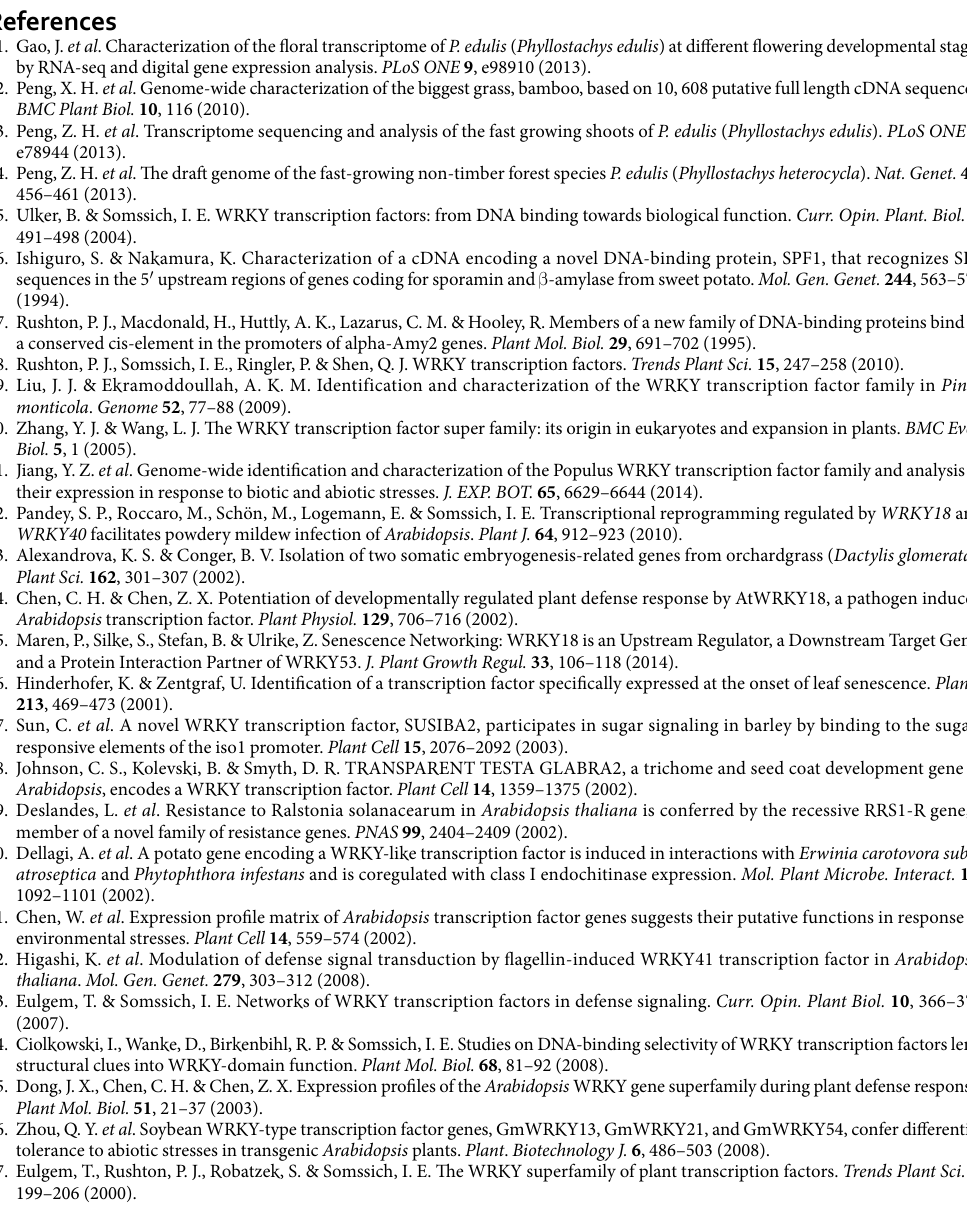
The construct vector was introduced into WT Arabidopsis plants (Columbia-0) by Agrobacterium -mediated transformation. Transgenic plants were selected on kanamycin, and the first generation of transgenic plants was examined in terms of their phenotypes. At least 10 independent transgenic plants exhibiting severe phenotypes were selected, subjected to phenotypic characterization and screened for the transgene. Transgenic Arabidopsis seeds (T3 generation) and WT seeds were cultured with 10% and 20% PEG solution on MS agar medium. One-week-old seedlings were used to observe the phenotype. Three-week-old transgenic plants and WT which growth in normal growth condition were treated with PEG solution for 3 h and further used for RT-PCR experi- ment and stomatal closure observation. The subcellular localization of PheWRKY72-2 was performed by transfecting GFP-tagged PheWRKY72-2 into Arabidopsis sheath protoplasts. The full-length cDNA of PheWRKY72-2 was fused in frame with the GFP cDNA and ligated between the CaMV 35 S promoter and the nopaline synthase terminator. The fluorescence signals in transfected protoplasts were examined by a confocal laser scanning micro- scope (Leica